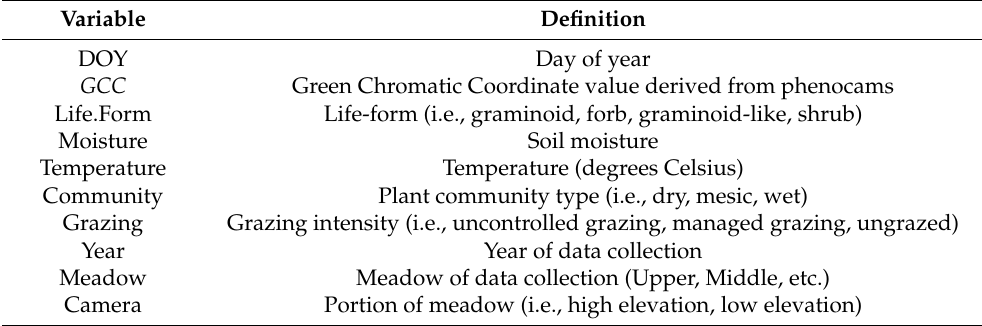
Table 2. List of variables used in the creation of a random forest model for the prediction of phenological stages in the